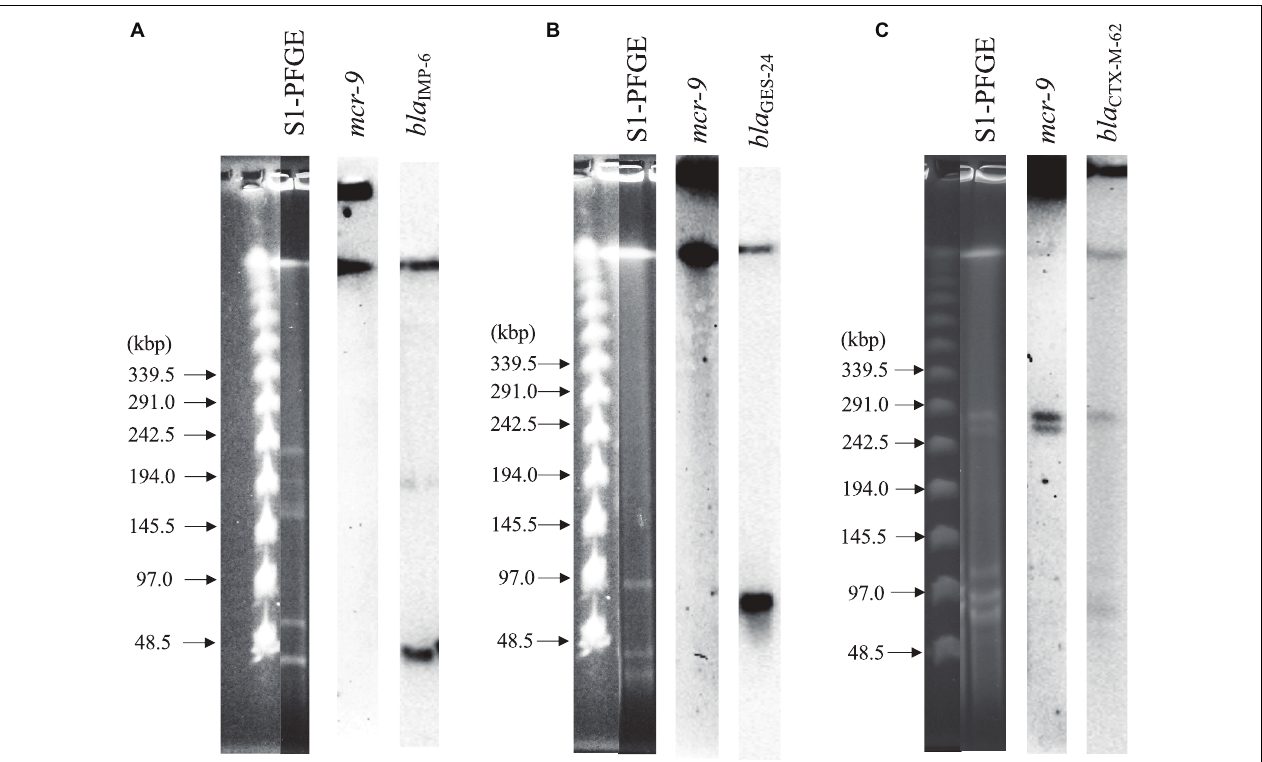
FIGURE 2 | S1-nuclease pulsed-field gel electrophoresis and Southern blot hybridization using three isolates with mcr-9 . (A) bla IMP − 6 + bla CTX − M − 2 -positive K. pneumoniae THUN262, (B) bla GES − 24 -positive E. kobei THUN627, and (C) bla CTX − M − 62 -positive E. coli THUN648.